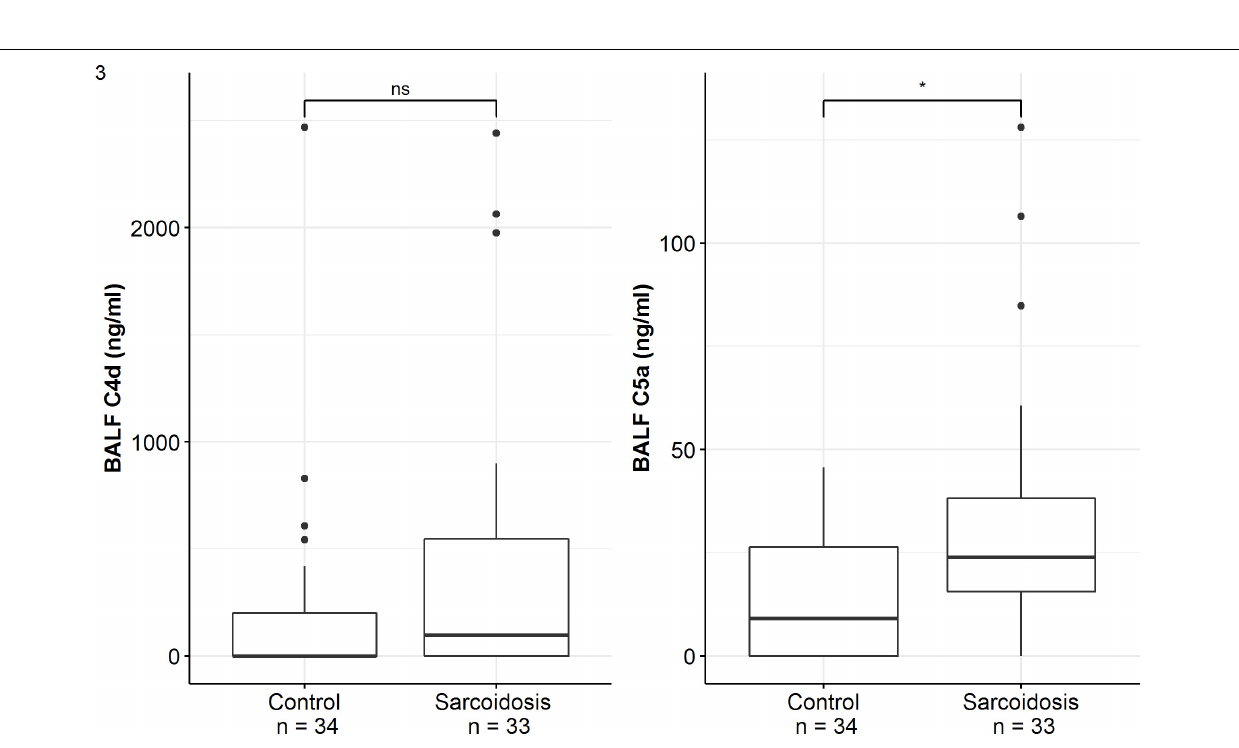
Frontiers in Immunology |